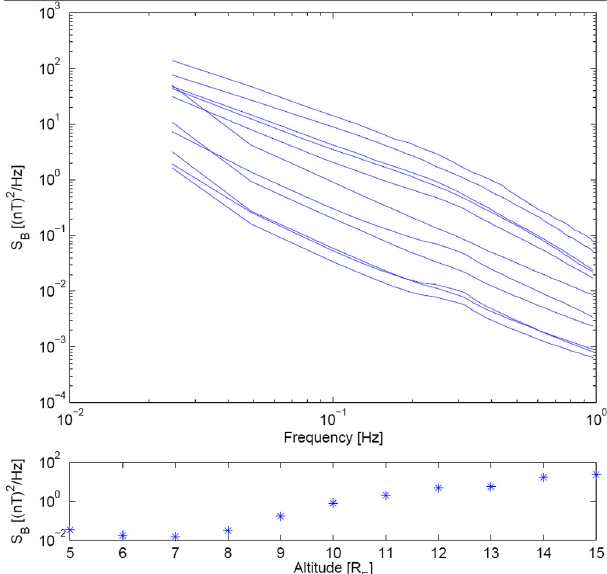
Fig. 3. Upper panel: the power spectral density for the magnetic field versus frequency observed at different geocentric distances (5– 15 R E ). Lower panel: the average spectral density at each altitude.